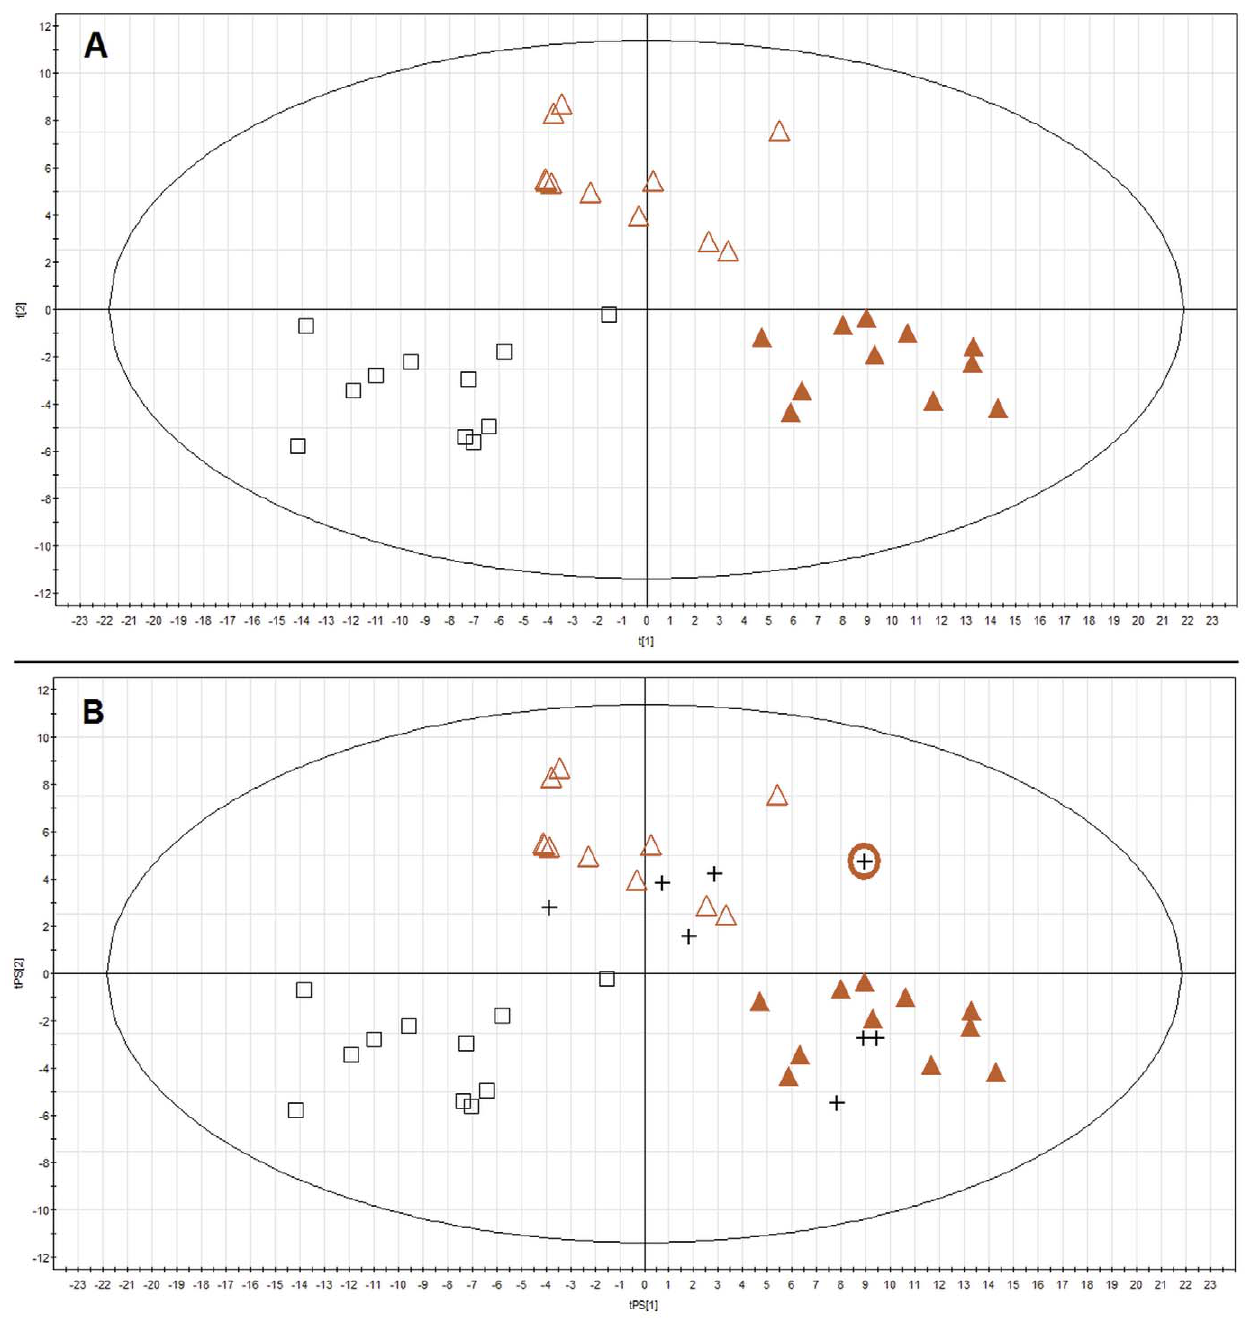
Figure 2. PLS-DA plot of plasma metabolic profiles obtained for age matched aneurysm patients and controls. n - small AAA, m – large AAA, + - predicted AAA samples not matching in age Panel A shows PLS-DA model (R 2 =0.835, Q 2 =0.335) for plasma samples obtained from patients and controls matching in age (n=11). Panel B shows prediction for additional samples of patients (4 with large and 4 with small AAA). Sample marked by the circle was obtained from the patient with AAA size of 5.4 cm, and was assigned to large AAA group because the patient was operated on.